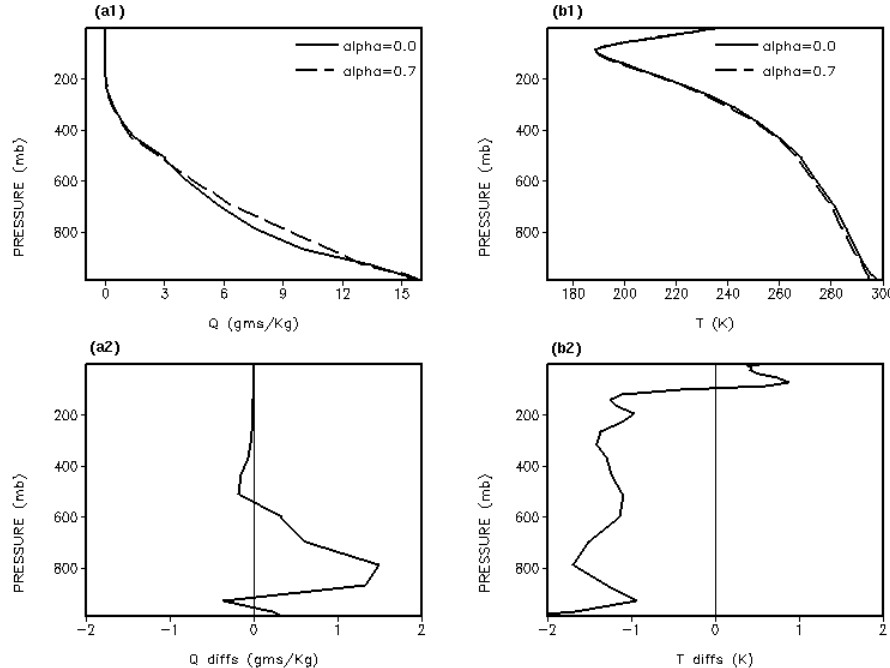
Fig. 9. Vertical profile of the the area averaged (0 to 360 and 7 ◦ S to 7 ◦ N), time mean, quantities, (a1) specific humidity for α =0.7 and α =0.0. (g/kg), (b1) atmospheric temperature for α =0.7 and α =0.0 (K). (a2) specific humidity difference between α =0.7 and α =0.0. (g/kg), (b2) atmospheric temperature difference between α =0.7 and α =0.0